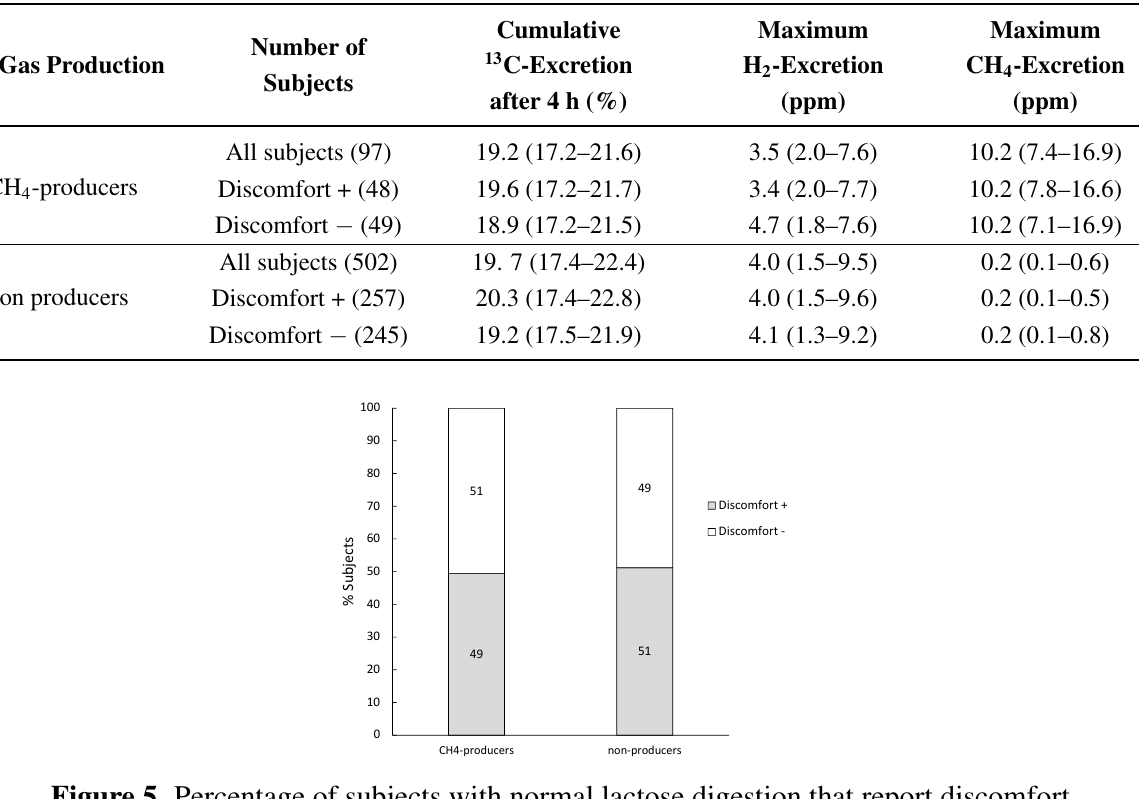
Figure 5. Percentage of subjects with normal lactose digestion that report discomfort.